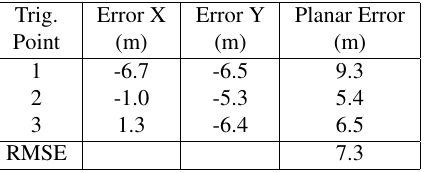
Table 7. The errors of CPs for the indirect method applied to 2 corrected maps in Thassos test site. Trig.